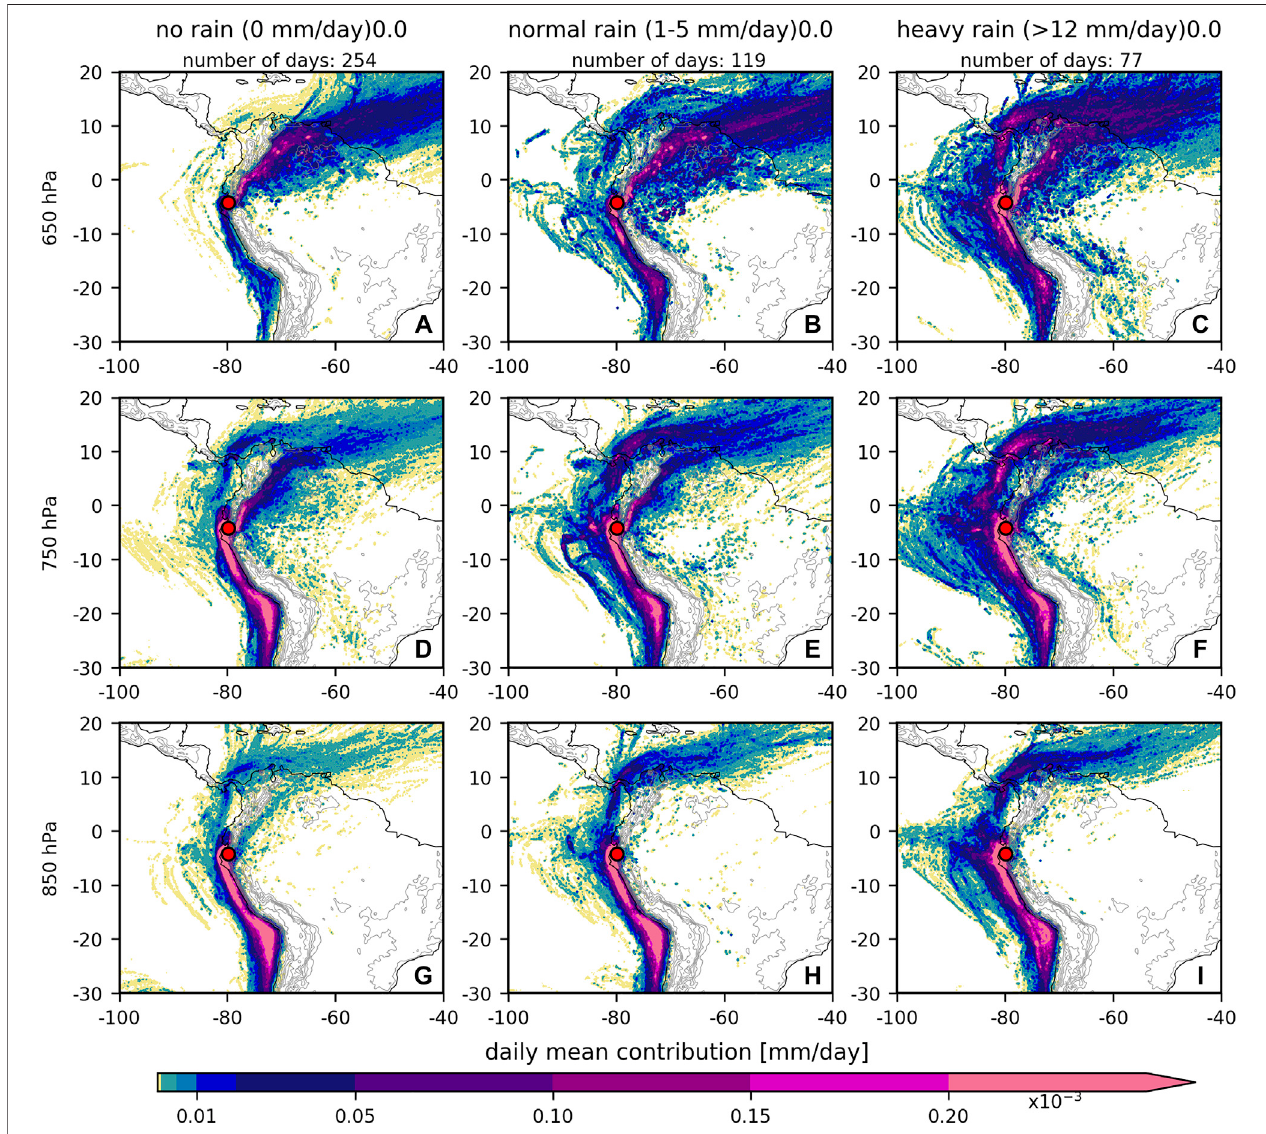
FIGURE 6 | Moisture source regions given as daily mean contribution (mm/day) to the precipitation at the study site for the pressure levels 850, 750 and 650 hPa andseparatedintothecompositesofrainamount( “ norain ” (A,D,G) , “ normalrain ” (B,E,H) and “ heavyrain ” (C,F,I) .Topographiccontours,with750 minterval,shownas gray